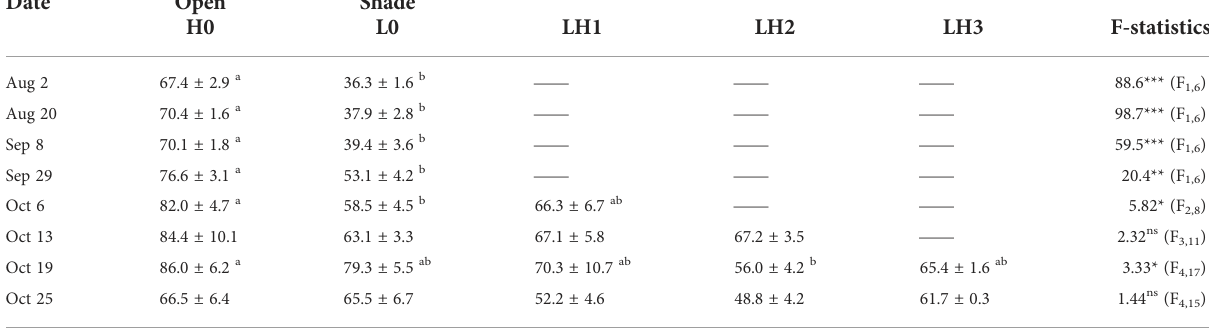
TABLE 3 Seasonal change in dry-mass based leaf sugar content (mg g -1 ) in leaves offullmoon maple seedlings grown under different light